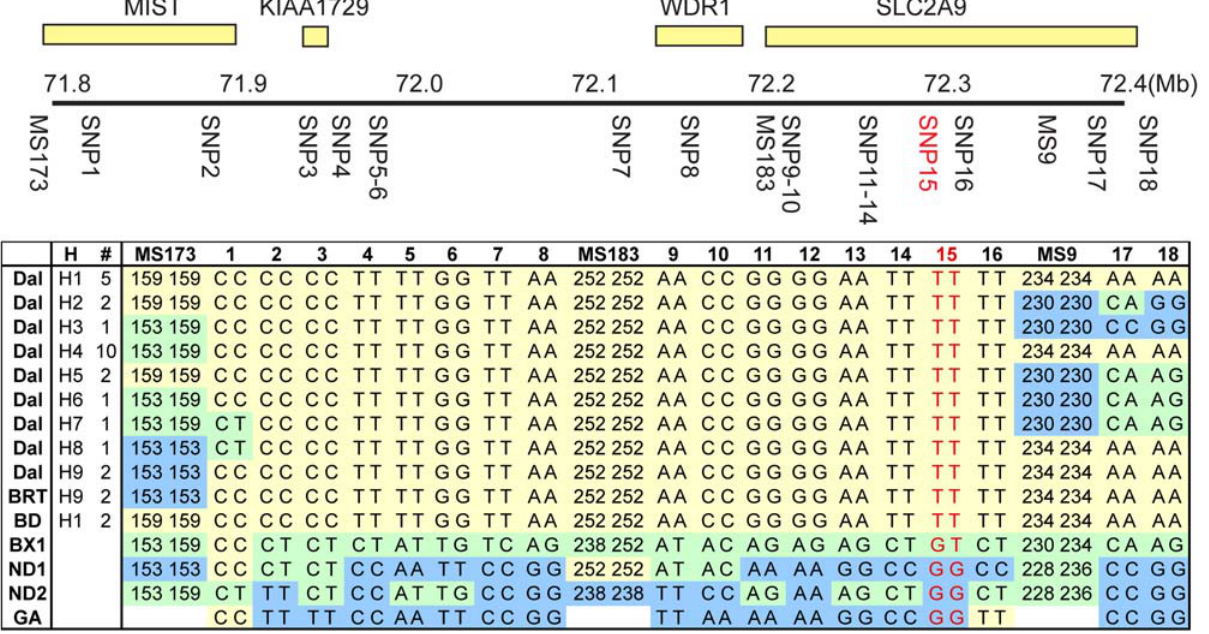
dogs. WDR1 was sequenced in liver cDNA and genomic DNA